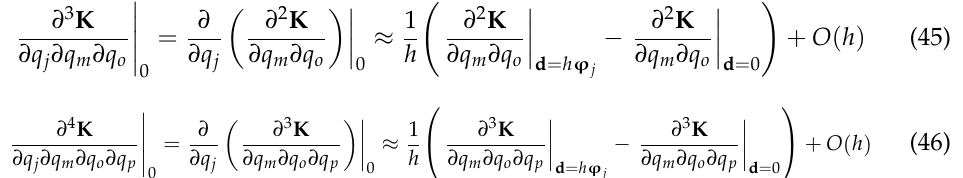
in the same manner as follows. puted